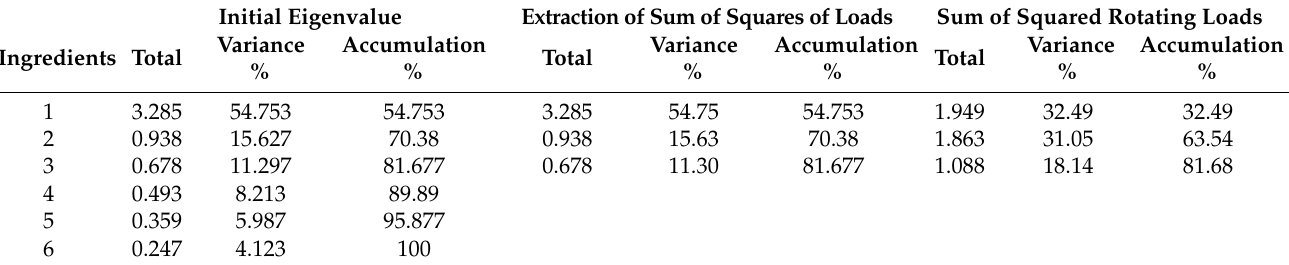
Table 5. The total variance